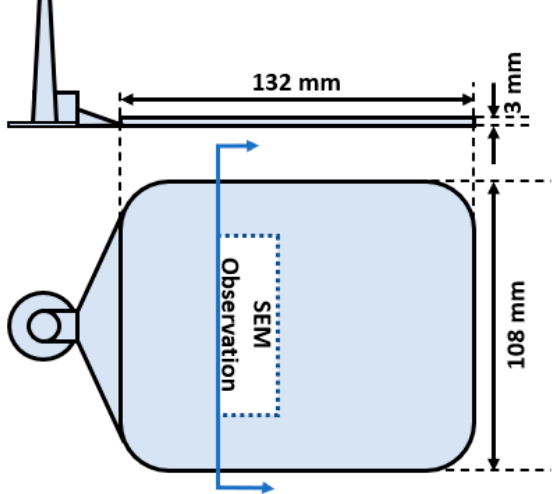
Figure 1. Schematic of the mold dimensions with the general area of SEM observations labelled. Detailed information on processing conditions is listed in Table 3. The majority of parameters were fixed, while the packing time was varied from 0.5 s to 20 s. A range of packing times was explored as a means to effectively vary the foaming temperature, which is the melt temperature when foaming is induced (i.e., when the mold opens in